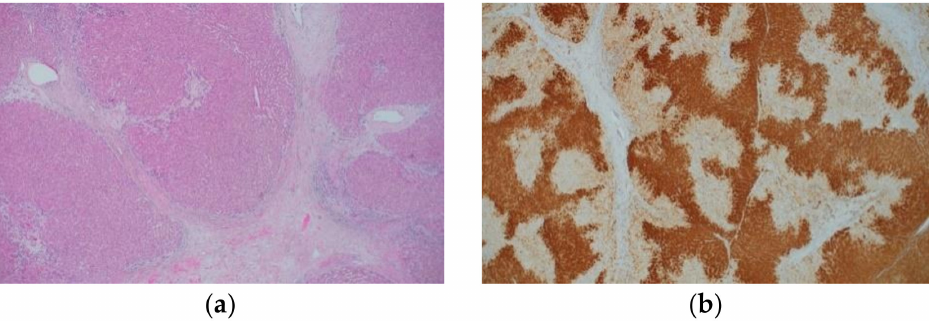
Figure 2. Histological appearance ( a ) and results of immunohistochemical staining ( b ) of focal nodular hyperplasia. ( a ) The lesion is characterized by thick fibrous septa with a central scar, thick- walled abnormal blood vessels, and ductular reaction. ( b ) Immunohistochemistry for GS shows a map-like staining pattern. (Original magnification: × 100 for ( a , b